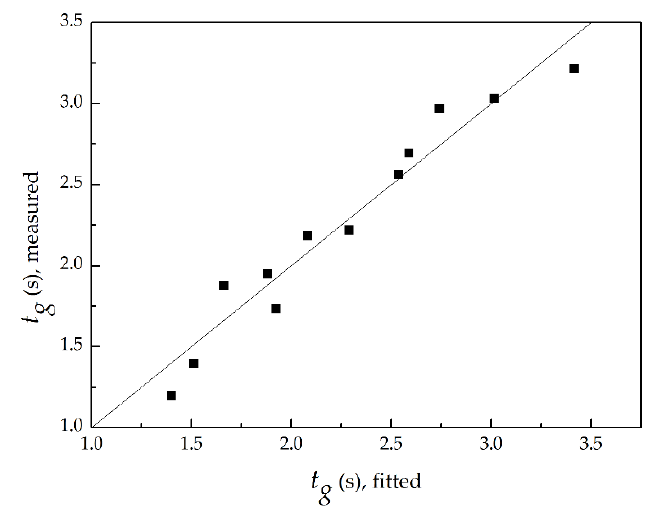
Figure 11. Prediction of global flame residence time from its correlation.